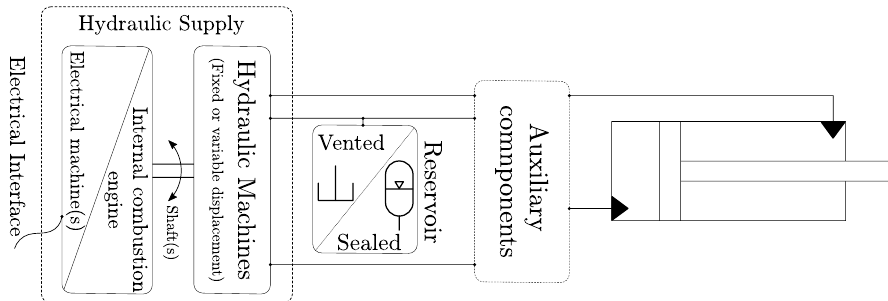
Figure 2. Conceptional illustration showing the subsystems constituting a pump-controlled differential cylinder drive as defined in this